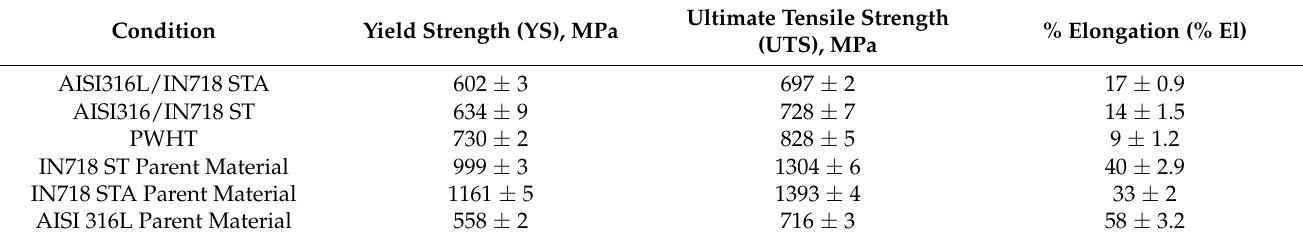
Figure 12. Tensile failure location of the dissimilar friction welds ( a ) AISI 316L-IN718 ST and ( b ) AISI 316L-IN718 STA and ( c ) PWHT.